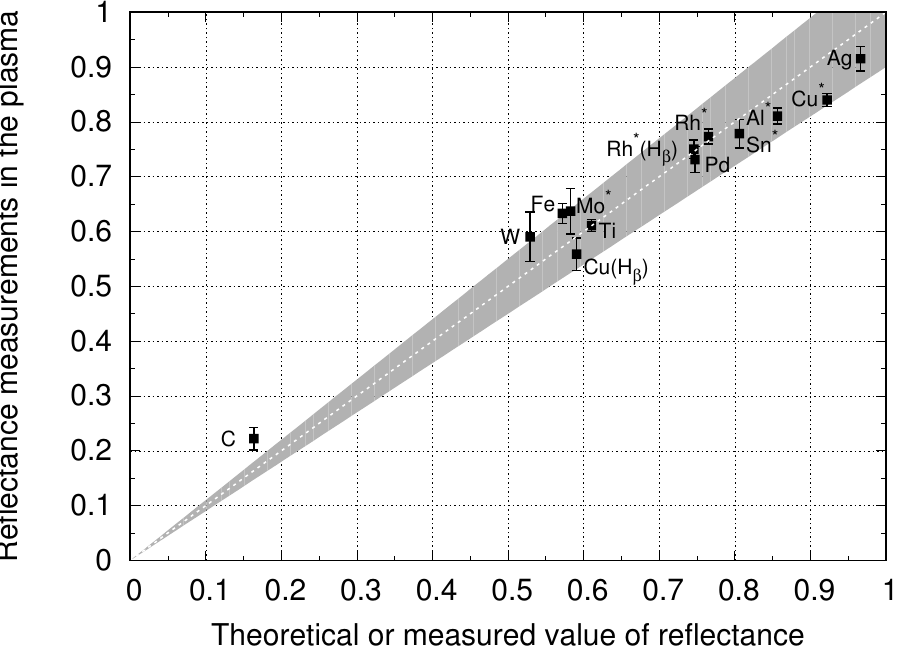
Figure 9. Comparison between the measured values of reflectance in the plasma and theoretical data or measurements in the laboratory. The last values are marked with ∗ . The gray zone shows the region of deviation within 10%. The measured values of reflectance at the Balmer- α for C, Al, Fe, Ag, Sn, and W are taken from